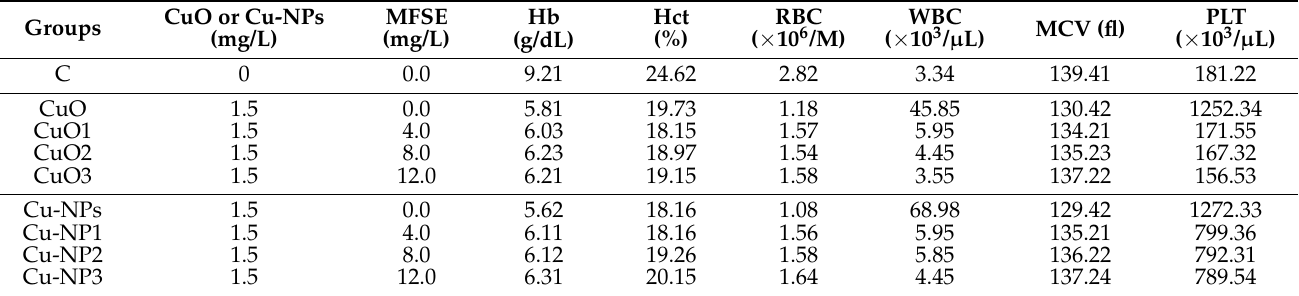
Table 5. Value of different hematological parameters (mean ± SE) measured in the common carp C. carpio experimentally treated with 1.5 mg/L of CuO or Cu-NPs alone, and with different doses of MSFE, besides the control group (C) (Hb: hemoglobin; Hct: hematocrit; RBC: red blood cells; WBC: white blood cells; MCV: mean cell volume; PLT: